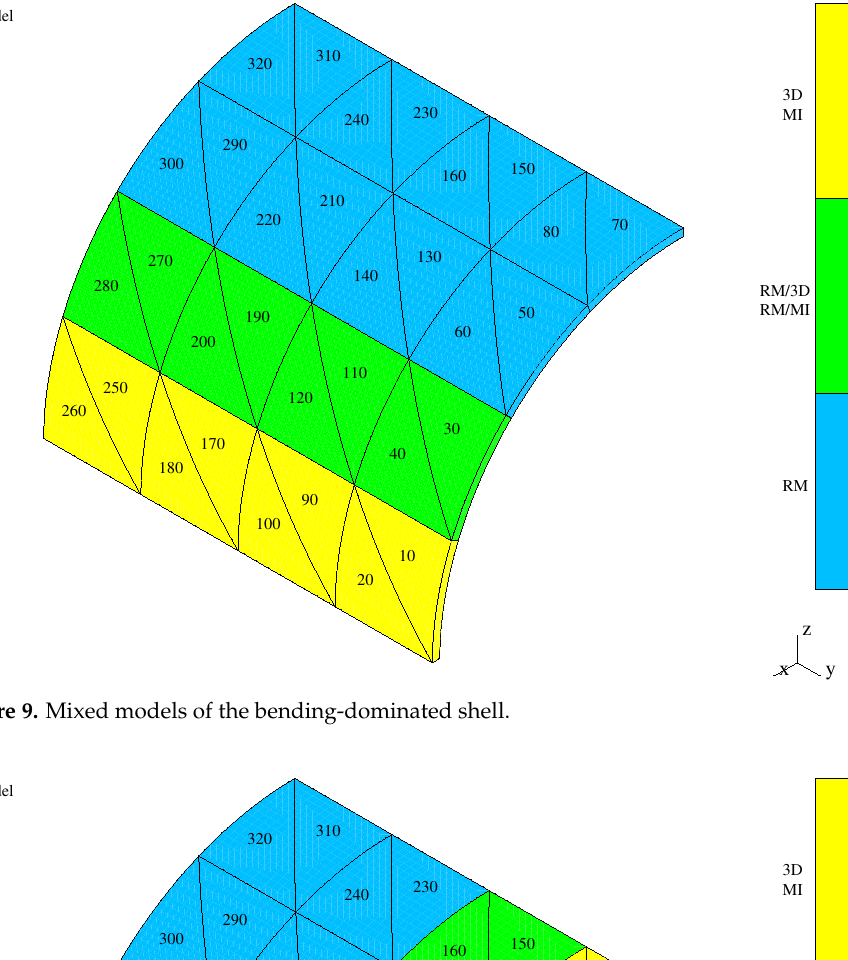
Figure 9. Mixed models of the bending-dominated shell.